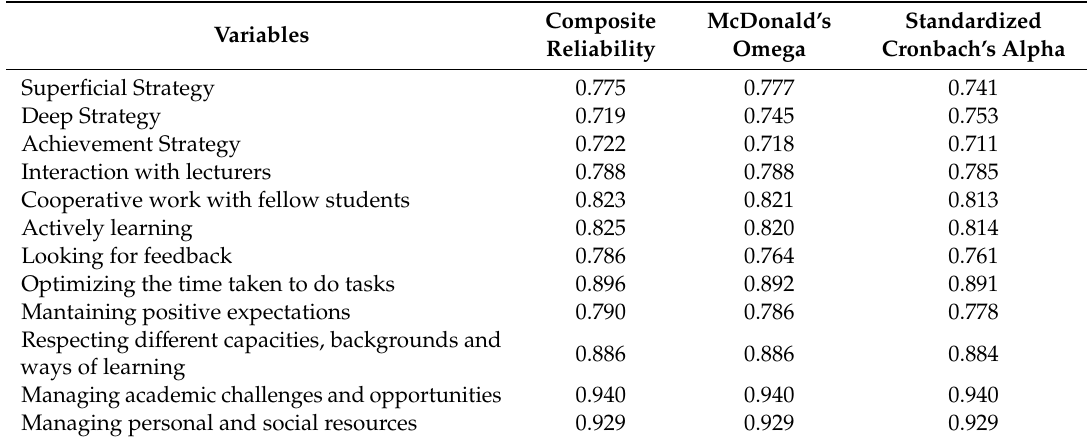
Table 1. Values of CR, Ω and St. α of the CEPEA and IBPEU scores.